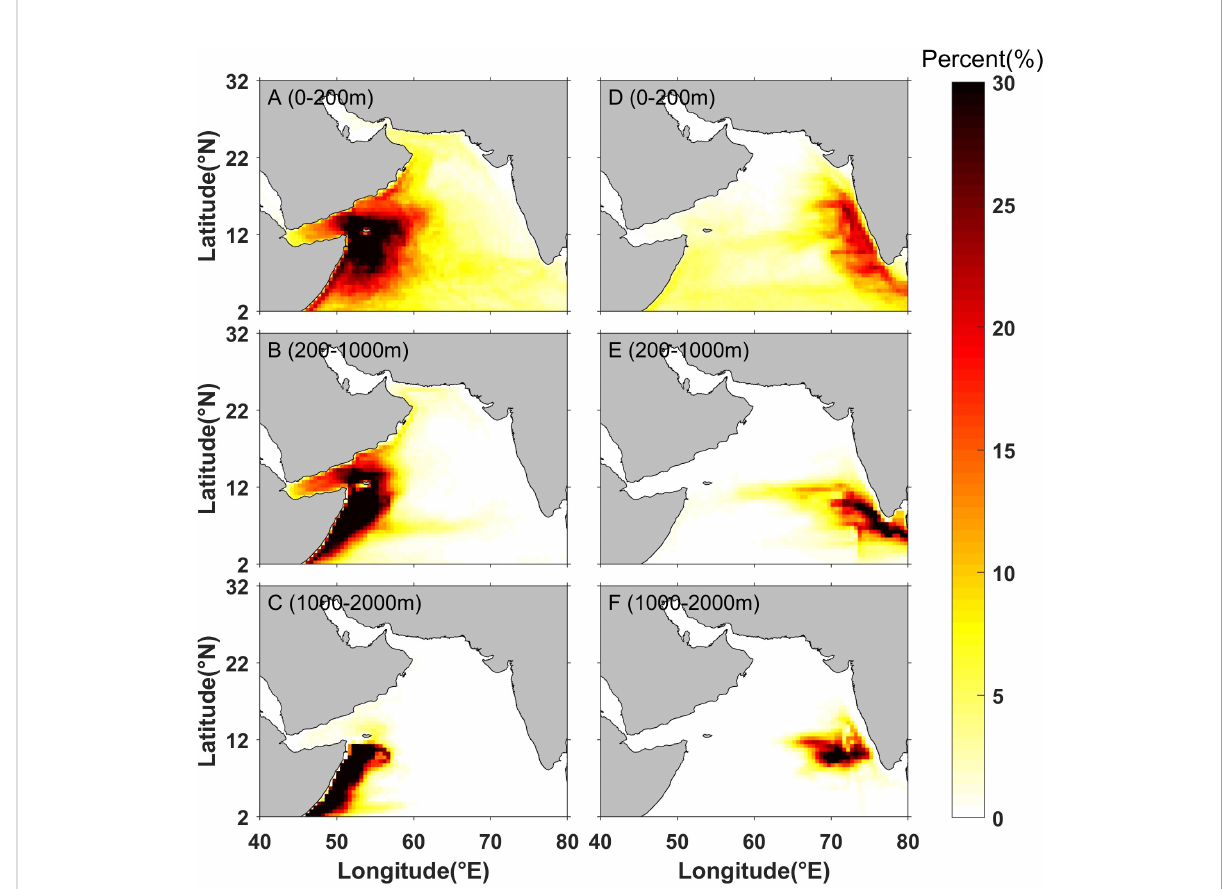
FIGURE 6 Transport pathways of particles 5 years after being released in different sources ( A – C , released in the west of southern boundary at 10°N in the Arabian Sea; D – F , released in the east), and being released at different depths ( A, D released at depths ranging from 0 to 200 m; B, E released at depths ranging from 200 to 1,000 m; C, F released at depths ranging from 1,000 to 2,000